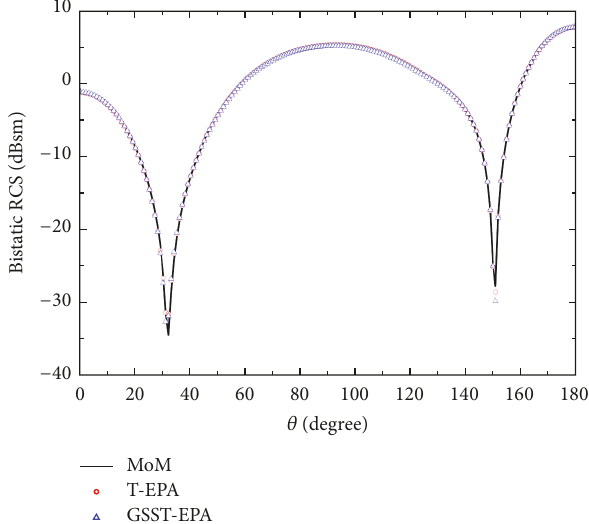
Figure 7: The bistatic RCS of two PEC spheres with center distance 1.0m.